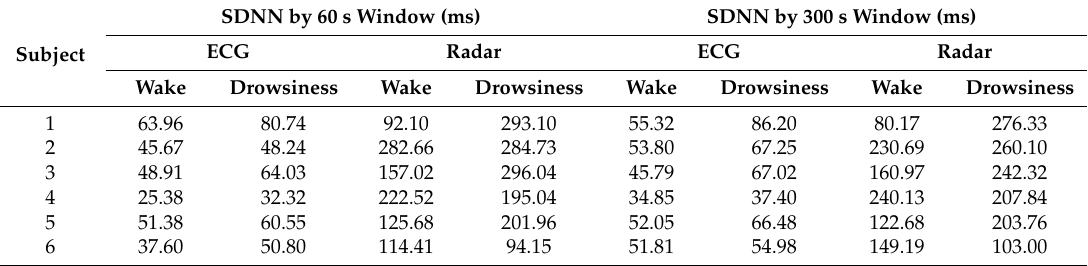
Table 5. The average of SDNN in the wake–drowsiness state obtained from the analysis